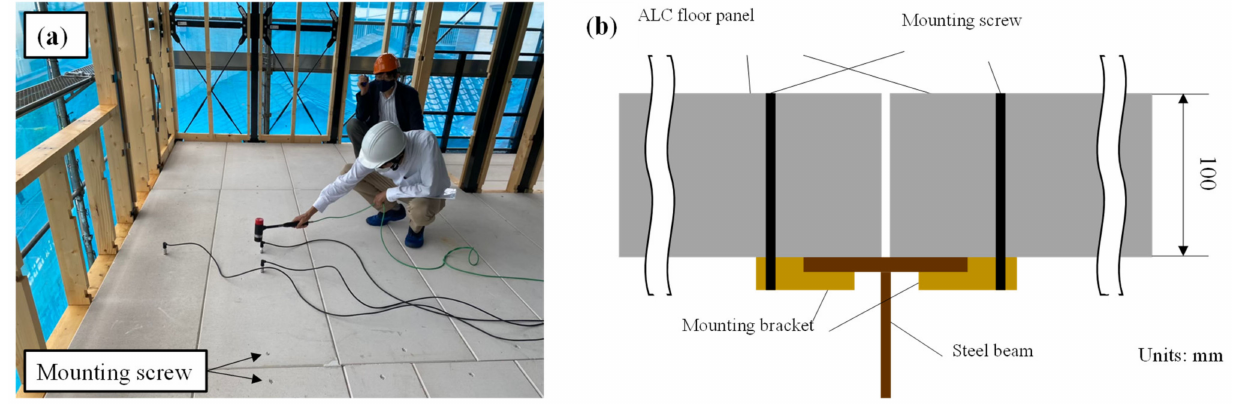
Figure 2. ( a ) Photograph showing hammering of ALC panels; ( b ) detailed cross-sectional schematic around mounts connecting ALC floor panels to steel